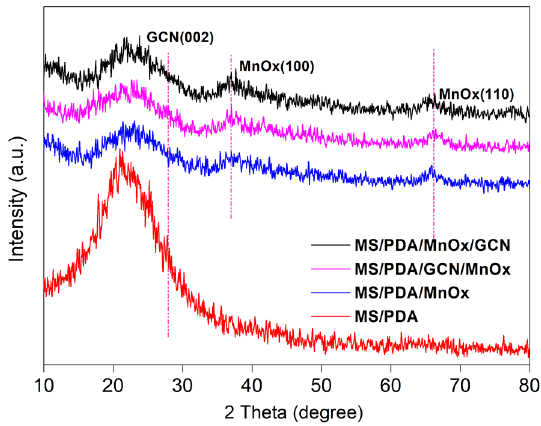
Figure 4. XRD profiles of the catalysts MS/PDA, MS/PDA/MnOx, MS/PDA/GCN/MnOx and MS/PDA/MnOx/GCN.